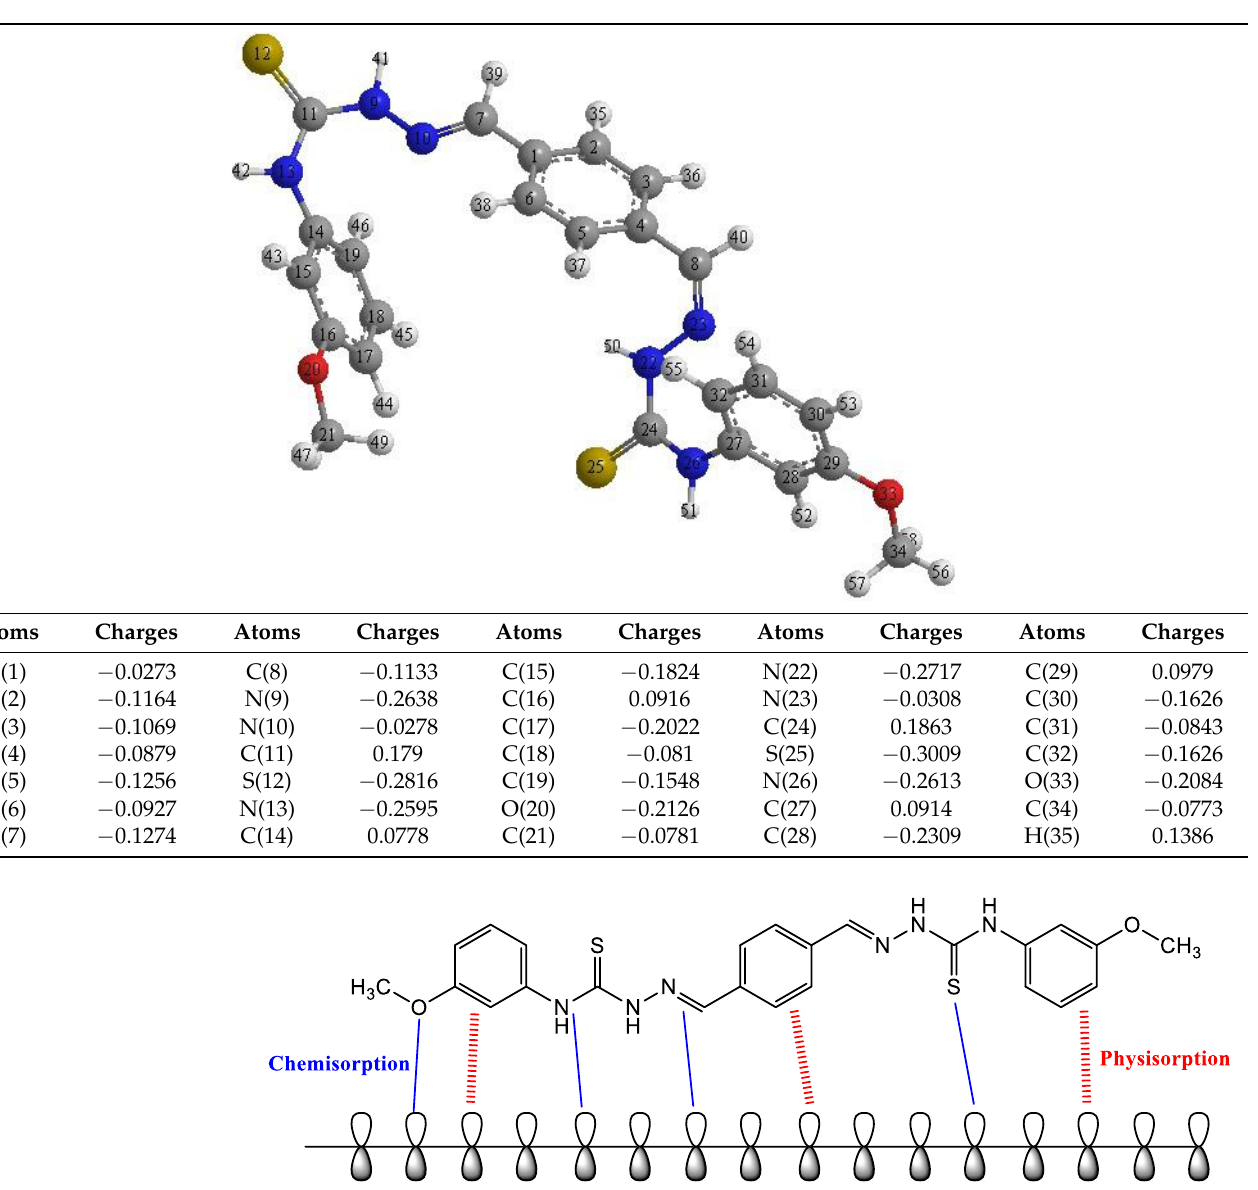
Figure 12. Suggested corrosion-inhibition mechanism of mild steel in 1 M HCl with the addition of the examined